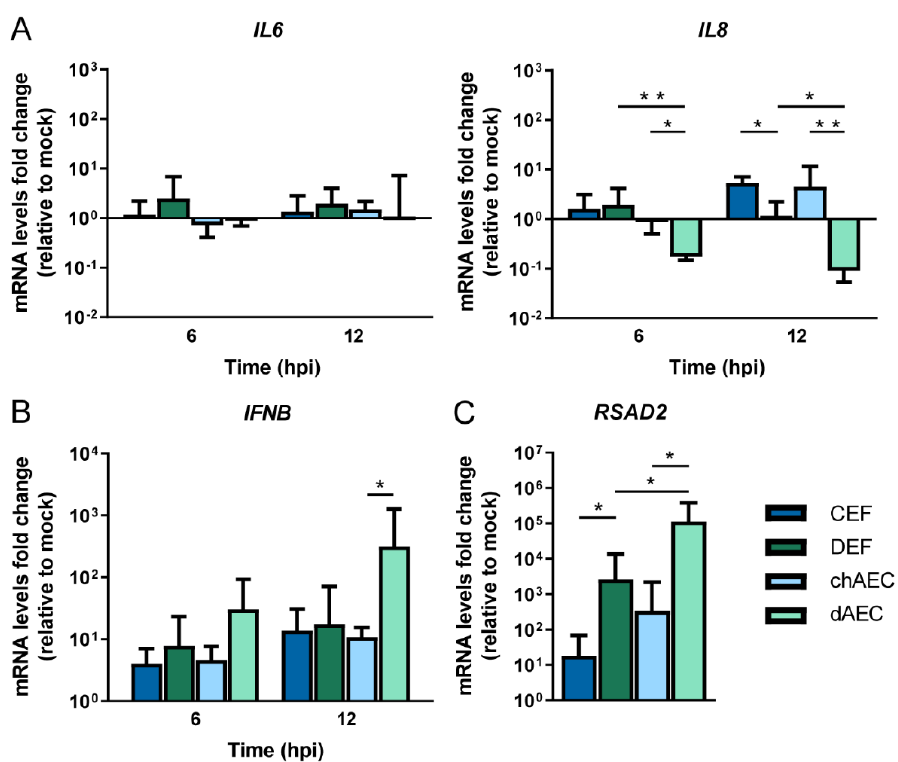
Figure 4. Host innate immune responses of avian primary cells upon HPAIV H5N1 inoculation. Monolayers of CEF, DEF, chAEC, and dAEC were inoculated with A/Vietnam/1203/04 H5N1 virus isolate at an MOI of 1. The cells were harvested at 6 and 12 hpi and analyzed for gene expression differences as compared to mock-inoculated cells. Messenger RNA levels were determined by a nucleic acid dye-based ( A , C ) or primer/probe ( B ) RT-qPCR. Fold changes were calculated using the 2 −ΔΔCT method with GAPDH serving as a housekeeping gene for normalization. ( C ) contains data from the 12 hpi time point. Bars indicate three biological replicates, and the error bars represent the SD. Statistically significant differences were determined on log-transformed fold changes by one- way ANOVA, followed up with individual unpaired t-tests. Only intra-species or intra-cell type significances are depicted. * p < 0.05; ** p < 0.01.